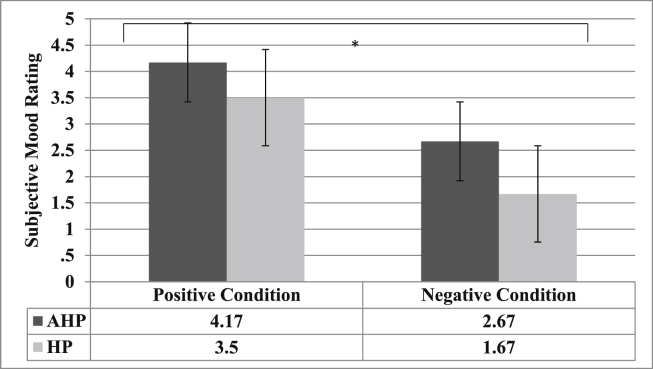
Marginal means and interquartile range (error bars) of emotion ratings for AHP (Dark grey bars) and HP (light grey bars) groups after positive and negative mood induction: *p < .05. The Y-axis indicates the patient's subjective mood ratings on a scale from zero to five (0 = very unhappy; 5 = very happy).